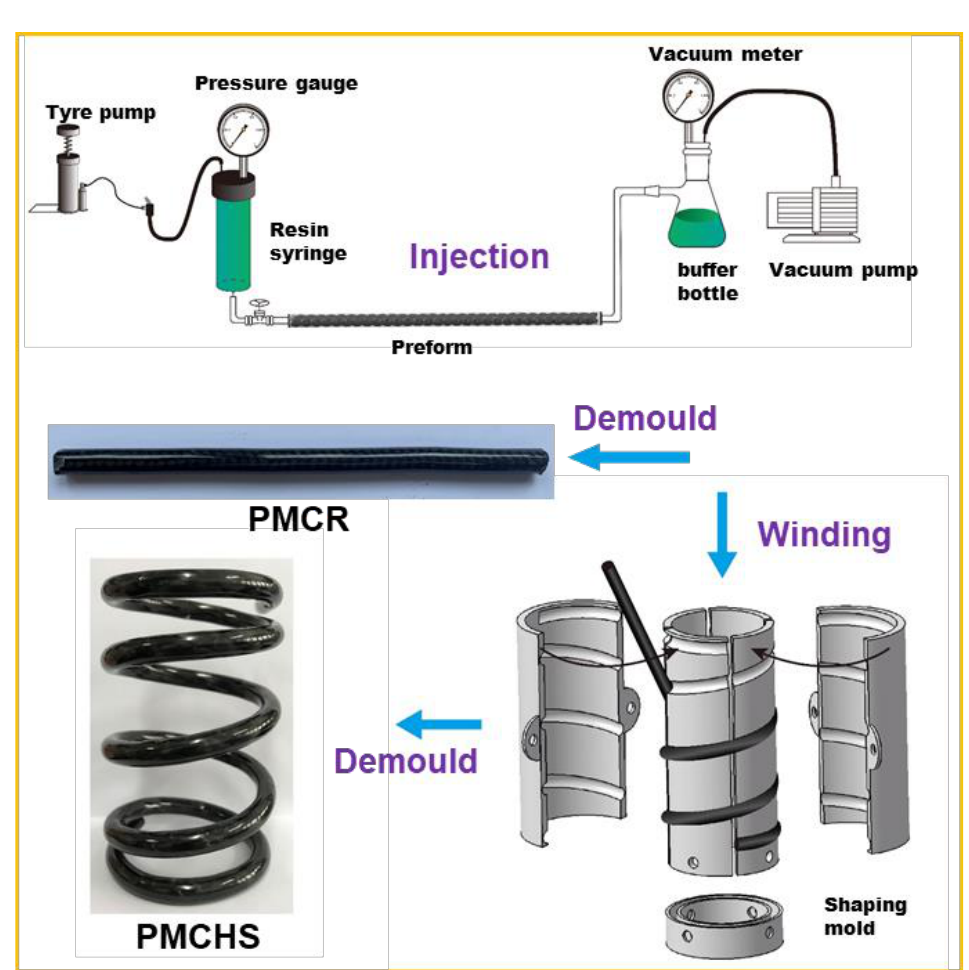
Figure 2. Schematical drawing of manufacturing PMCRs and PMCHSs based on an injection–winding technology.